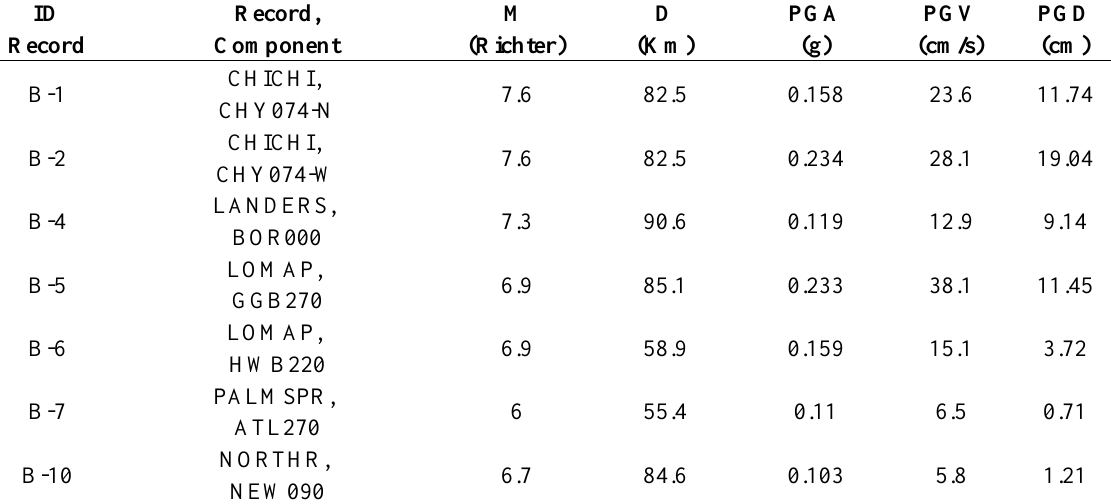
Table 5. Set of ground motion records in soil type B.